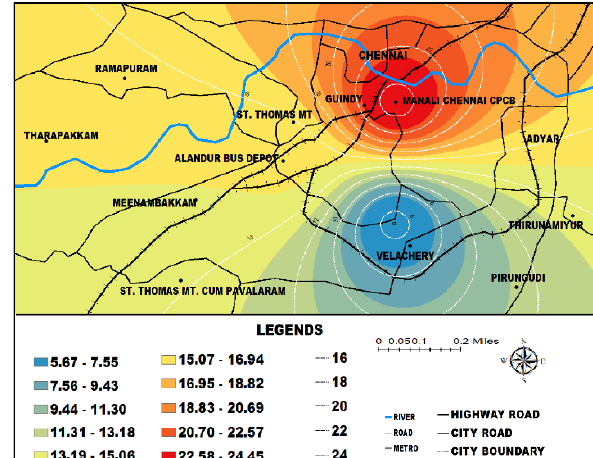
Figure 12. Air quality map of Chennai January monthly average based on SOx (µg/m 3